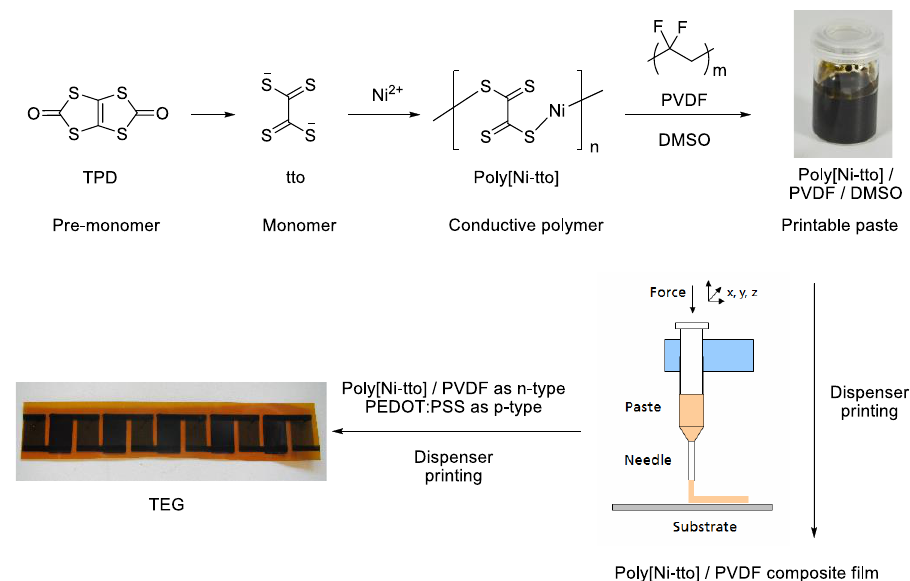
Figure 1. Scheme of the polymer preparation and generator fabrication.